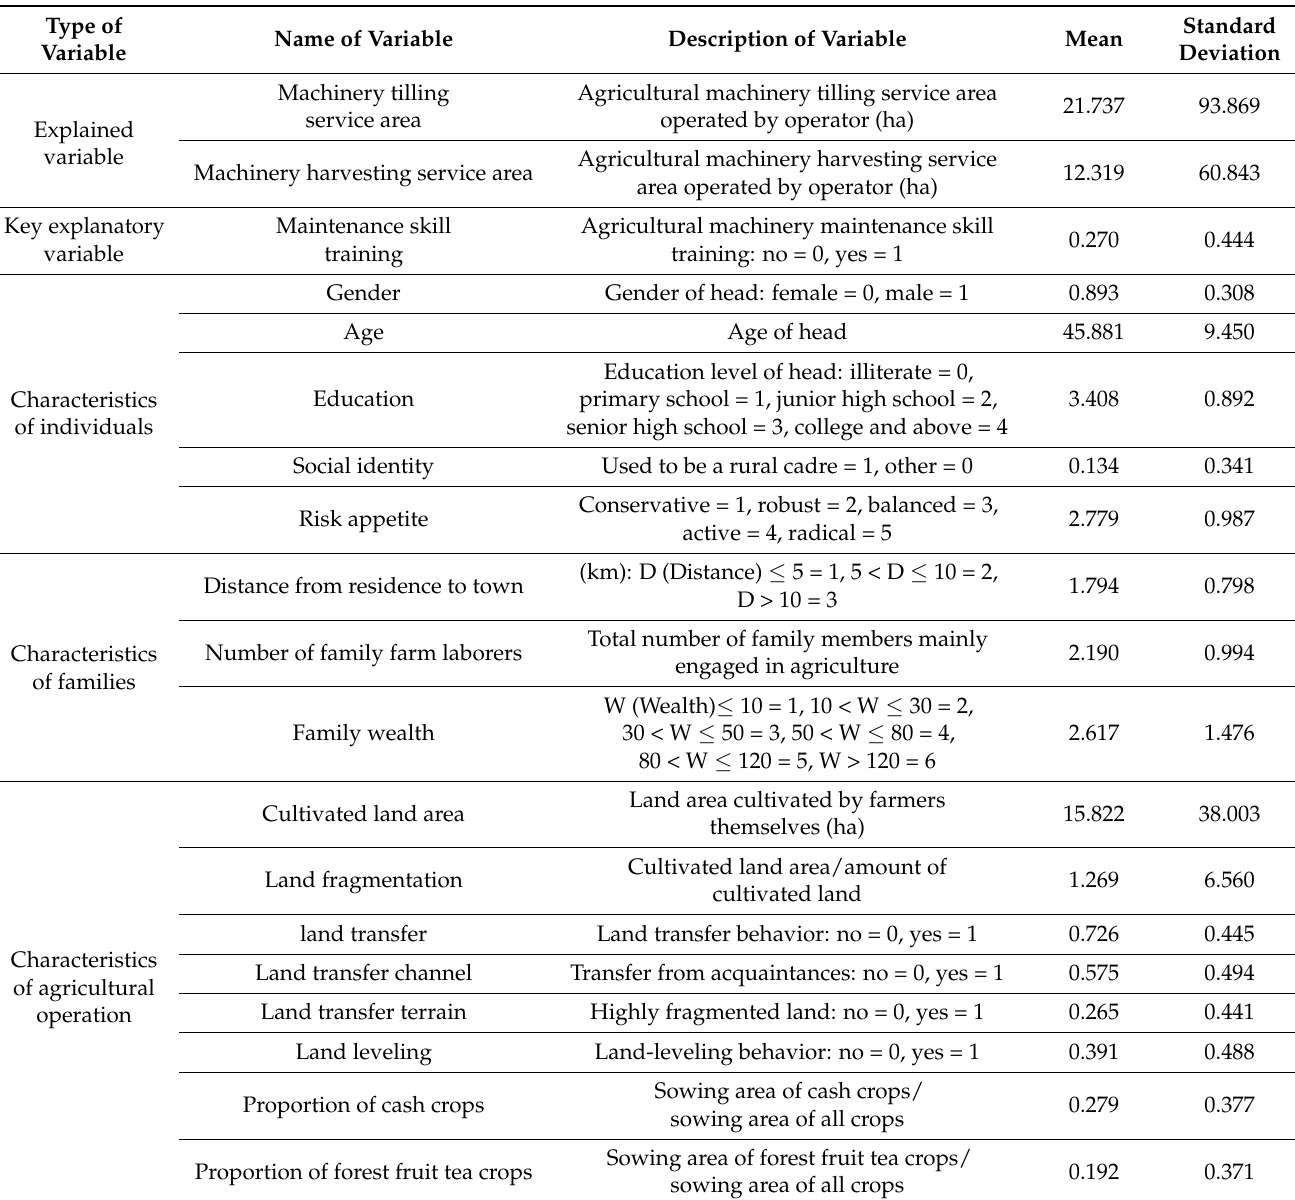
Table 1. Summary of